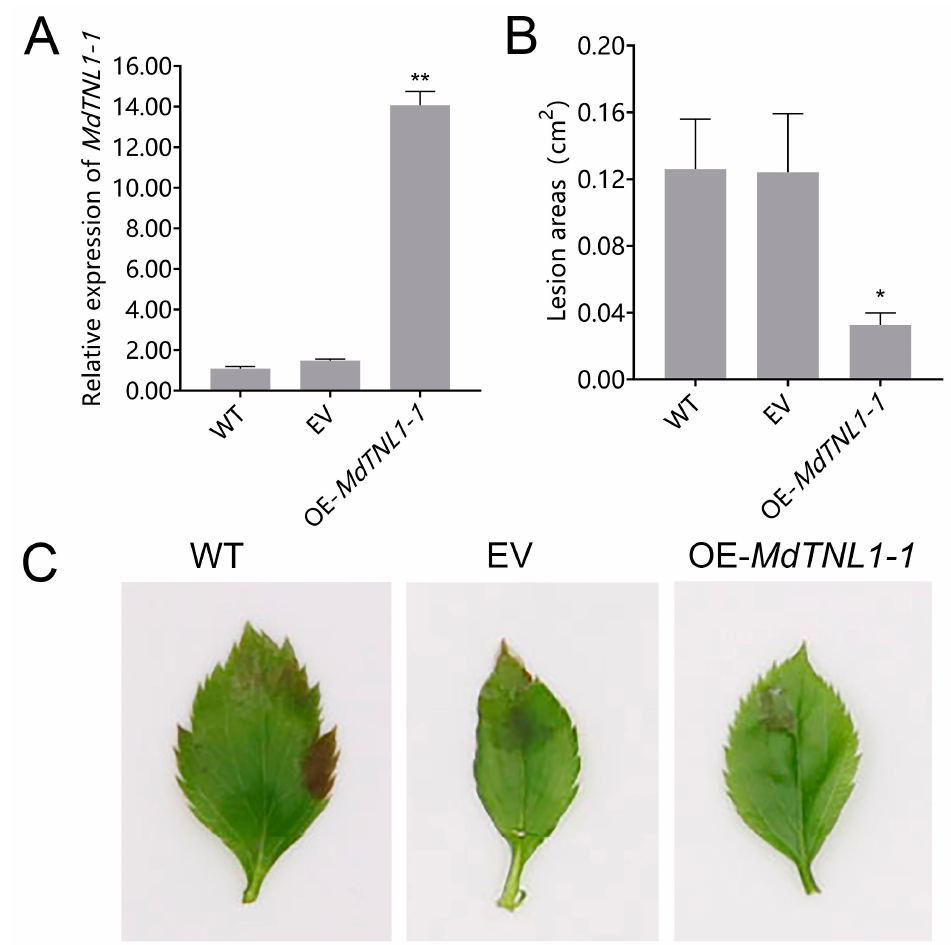
Figure 5. Effects of MdTNL1-1 gene on the resistance of ‘Gala 3 ′ leaves to C. fructicola. ( A ) MdTNL1-1 transcript levels of leaves from ‘Gala 3 ′ overexpressing MdTNL1-1 or empty vector (EV: pCAM- BIA1300) and WT plant 4 days after C. fructicola infection. ( B ) Statistics of lesion areas in leaves 3 days after inoculation with C. fructicola in transient expressed leaves. ( C ) The phenotypes of leaves from transient expressed leaves 4 days after C. fructicola infection. Data (A,B) are presented as means ± SD of three biological replicates. Different asterisks indicate a significant difference. Asterisk indicates significant difference compared to WT (* p < 0.05, ** p < 0.01; one-way ANOVA test by Tukey’s test).